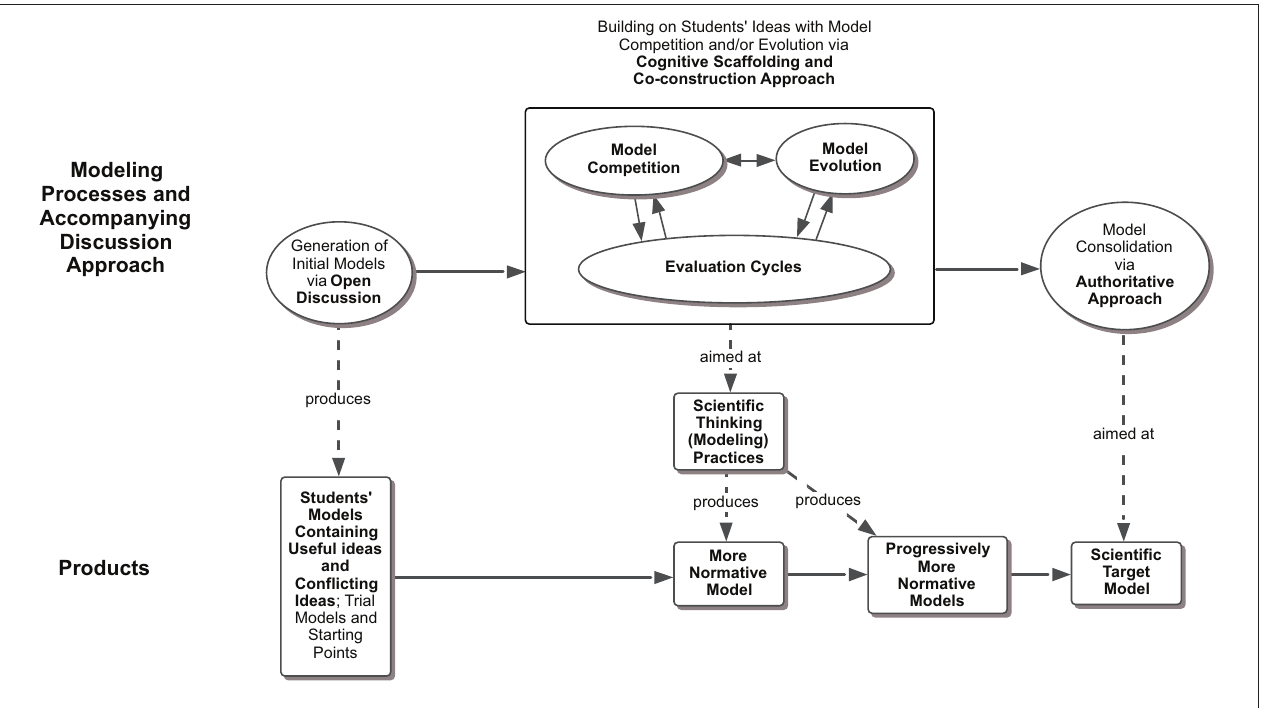
FIGURE 7 | Cognitive scaffolding of student modeling helps resolve tensions shown in Figure 1